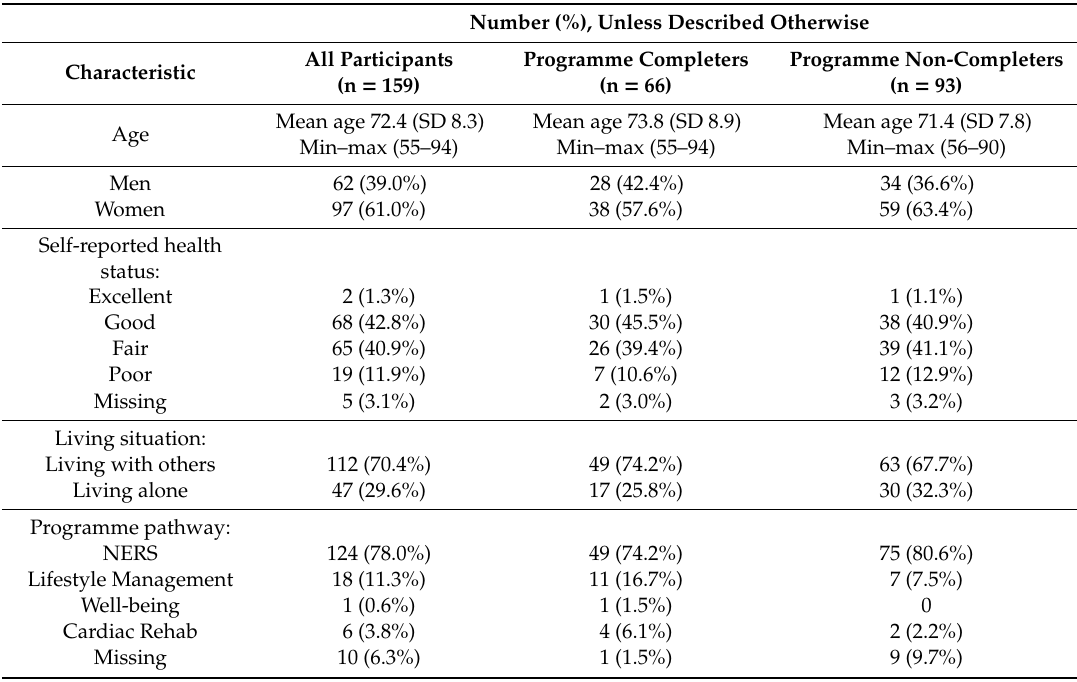
Table 2. Participant characteristics at